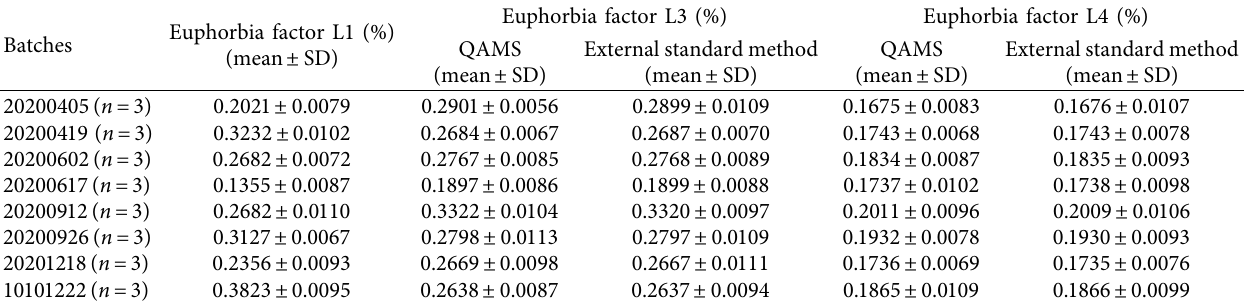
Table 9: Determination of euphorbia factor L1, euphorbia factor L3, and euphorbia factor L4 in Euphorbia lathyris L .